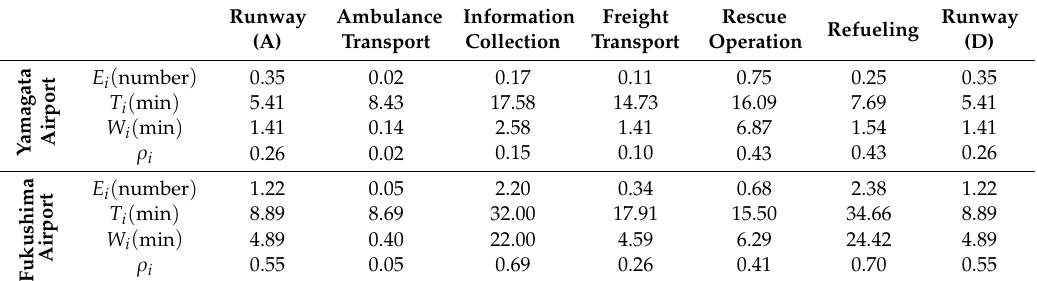
Table 8. Measured performance when applying FCFS: Yamagata Airport and Fukushima